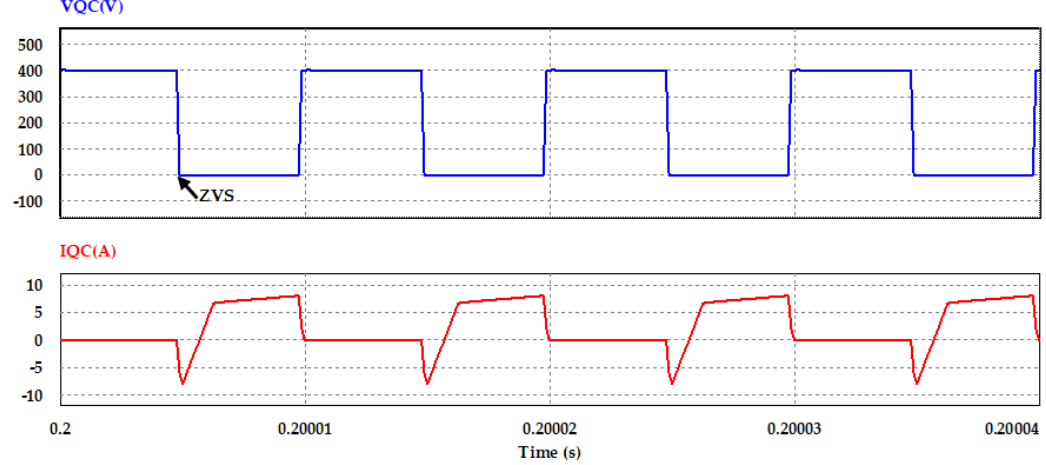
Figure 16. Voltage and current waveforms of switch QC in converter primary side at Po = 2 kW.